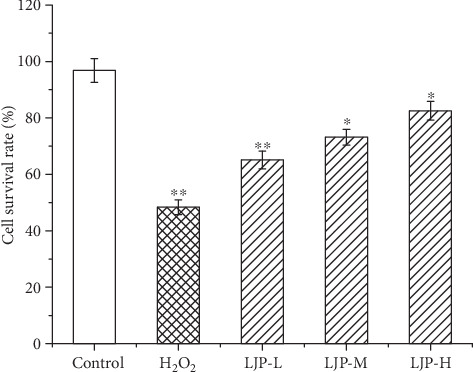
Effect of LJP on the cardiomyocyte survival of mice injured by H2O2. Percentages of cardiomyocyte survival rate were determined using MTT assay. Cardiomyocytes were incubated with different concentrations of LJP (10, 20, 40 μg mL−1) for 12 h. Control group was added 100 μL DMEM medium. H2O2 model group was added H2O2 (200 μmol L-1) 100 μL. Then, cardiomyocytes survival rate was determined. The results are expressed as mean ± SD (n = 10). Statistical significance was determined by One-Way Analysis (ANOVA). ∗P < 0.05, ∗∗P < 0.01 versus control groups.